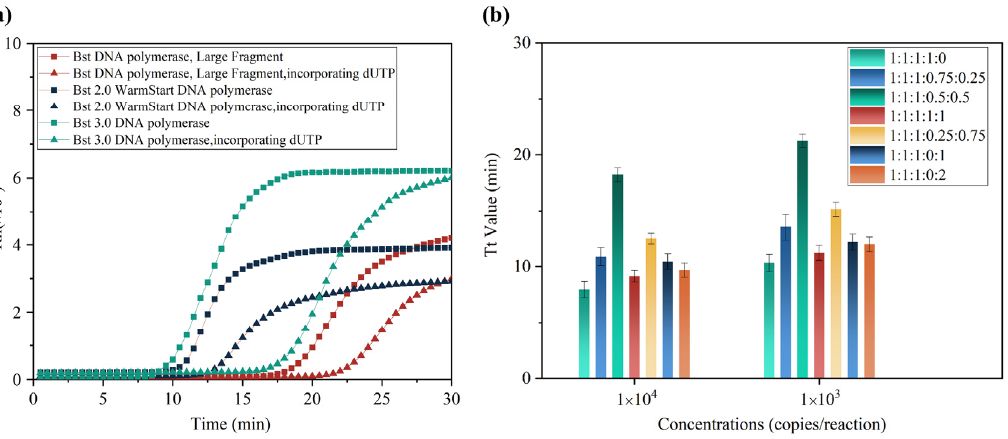
Figure 2. ( a ) Effect of different DNA polymerases and total replacement of thymine with uracil on the amplification efficiency of RT-LAMP reaction. ( b ) Optimization of uracil concentration in RT-LAMP reaction system.